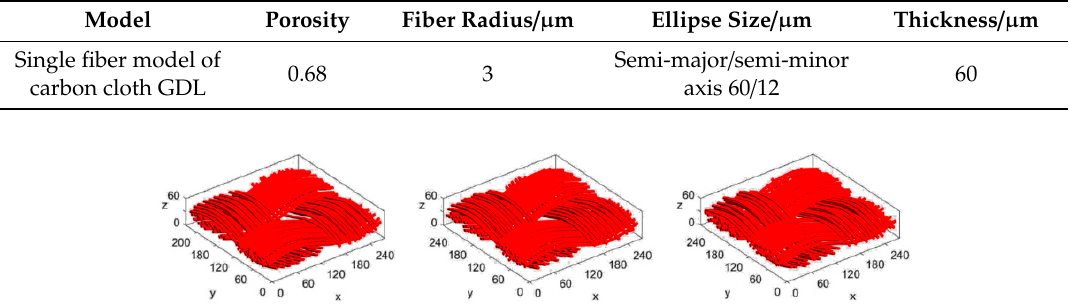
Figure 5. Three-dimensional stochastically reconstructed carbon cloth samples.